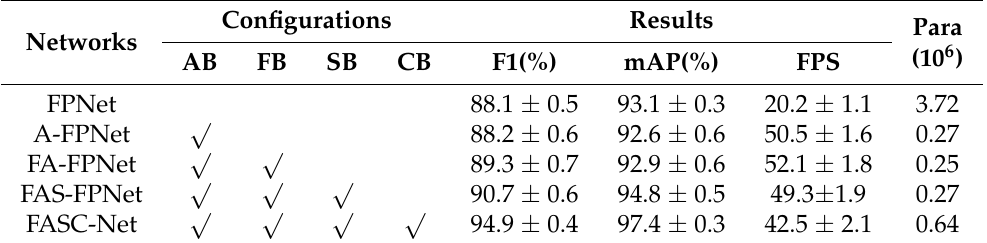
Table 9. The number of parameters, experimental results, and detailed configurations of those variants.